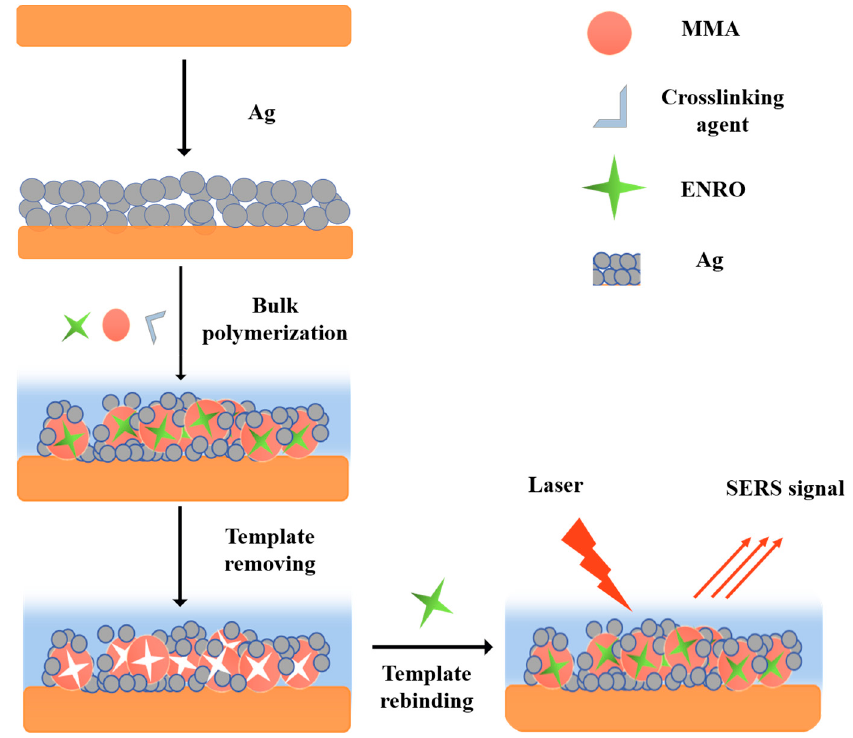
Figure 1. Preparation and recognition schematic diagram of Ag NPs–MIPs and SERS detection in ENRO.